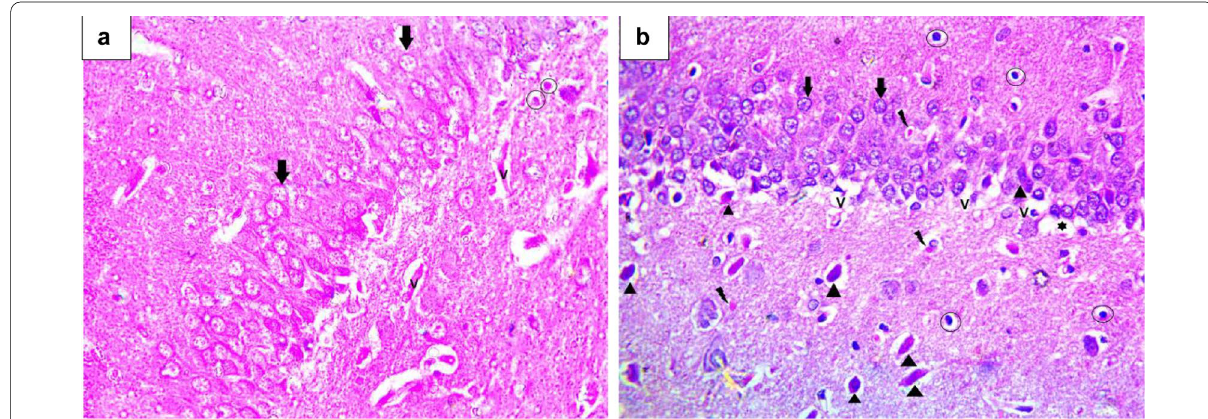
Fig. 2 Sections in the hippocampus for confirmation of neurodegeneration in the STZ animals. a Section from normal hippocampus showing normal thickness of the pyramidal layer with rounded granular cells (arrows). Astrocytes (circles) and blood vessels (V) are found in the molecular layer (Hematoxylin and Eosin 400) b Section from STZ‑induced AD hippocampus with CA2 showing some degenerated pyramidal cells with × neurofibrillary tangles (arrowheads) within the normal pyramidal cells (arrows), cell loss (asterisks) and other vacuolated cells (V) in the basal layer of pyramidal cells. Enlarged and excess astrocytes (circles) are found in the molecular layer (downward) and the polymorphic layer (upward). Depositions of amyloid protein (broken arrows) are found in the molecular layer (Hematoxylin and Eosin ×